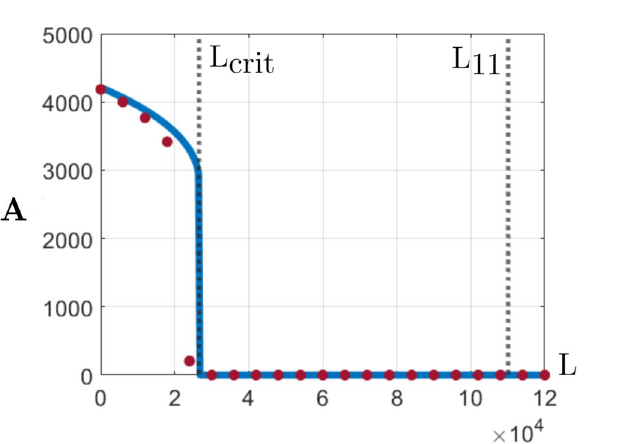
Figure 1. Three equilibria A The critical values L c ( K ) are calculated using Eq. (17) at K h , and K s - carrying capacities of the house blocks and streets.